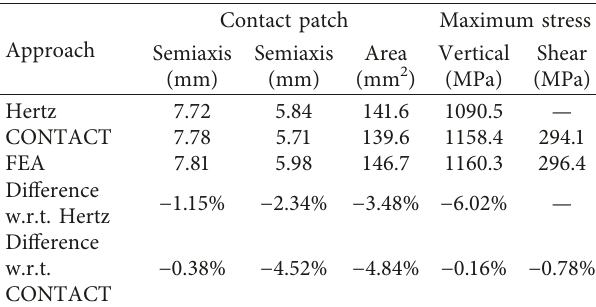
Table 2: Comparison of results from different methods.